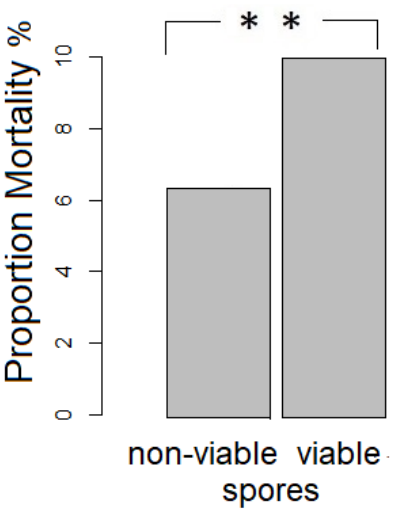
Figure 1. Significant differences in mortality between treatment groups including both larval and pharate state (N = 915, deaths non-viable spore exposure: 29, deaths viable spore exposure: 51).